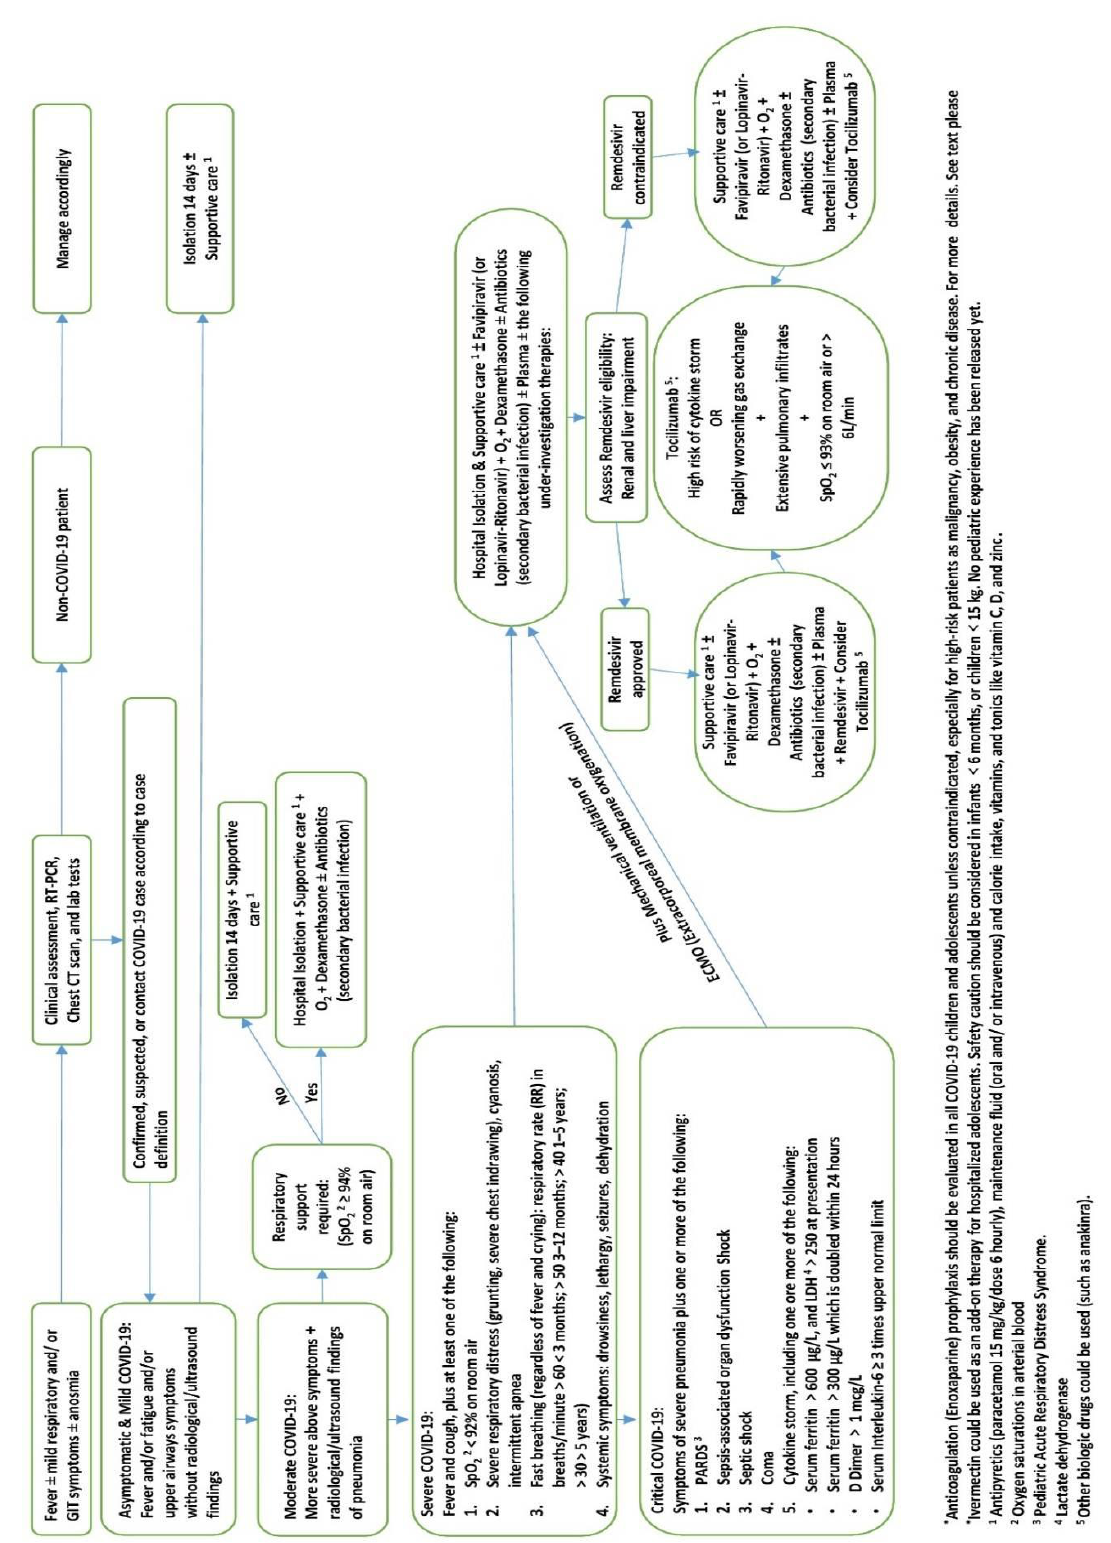
Fig. 1: Scheme of COVID-19 management in children and adolescents